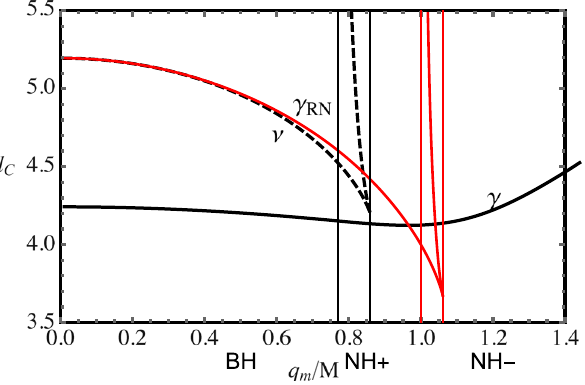
Fig. 2 Plots of photon ( γ ), neutrino ( ν ) circular orbit impact param- eters l C (it determines the radius of the BH shadow) as functions of magnetic charge parameter q m in effective-Bardeen and Bardeen space- times. For comparison with the NED case we constructed the plot of l C for the case of null geodesics in Reissner–Nördström spacetime where wesetthespecificcharge q RN = q m = q (curve γ RN ).IntheRNspace- times, there are three distinct regions – the first one with q m ≤ 1 for black hole spacetimes, demonstrates one photon orbit impact parameter √ for given magnetic charge, the second one with 1 < q m ≤ 3 /( 2 2 ) for naked singularity spacetimes, demonstrates two photon orbit impact parameters for any given magnetic charge, and the third one of the par- √ ticular naked singularity spacetimes with q m > 3 /( 2 2 )